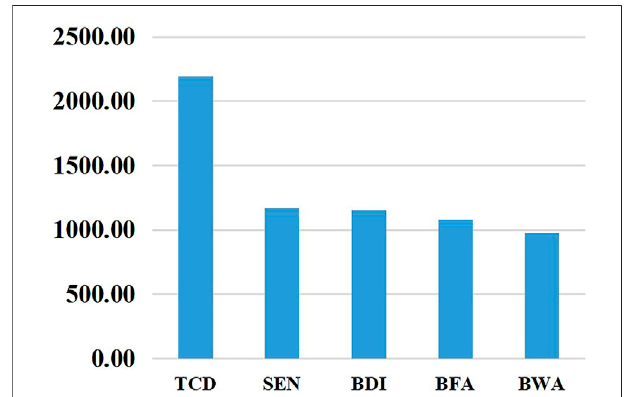
FIGURE 1 | Highest (inef fi cient). country-speci fi c business environment in SSA. note: TCD, Chad; SEN, Senegal; BDI, Burundi; BFA, Burkina Faso; BWA, Botswana; NAM, Namibia; ZWE, Zimbabwe; GNQ, Equatorial Guinea; NER, Niger; GHA, Ghana. Trends are measures on averages of the six indicators of TF [costs, documents, and time (to import and export)]. Source: Author ’ s computation with data from World Bank WDI